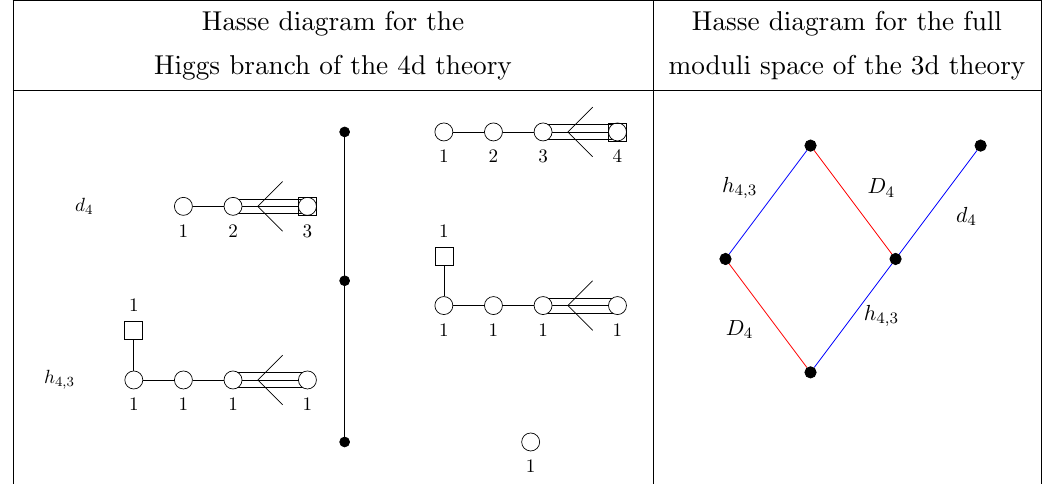
Table 7 . A 3 theory. Left : Hasse diagram for the Higgs branch of the 4 d the right of the Hasse diagram are the magnetic quivers for the closures of the leaves and to the left are magnetic quivers for the slices. Right : Hasse diagram for the full moduli space of the theory in 3 d = N